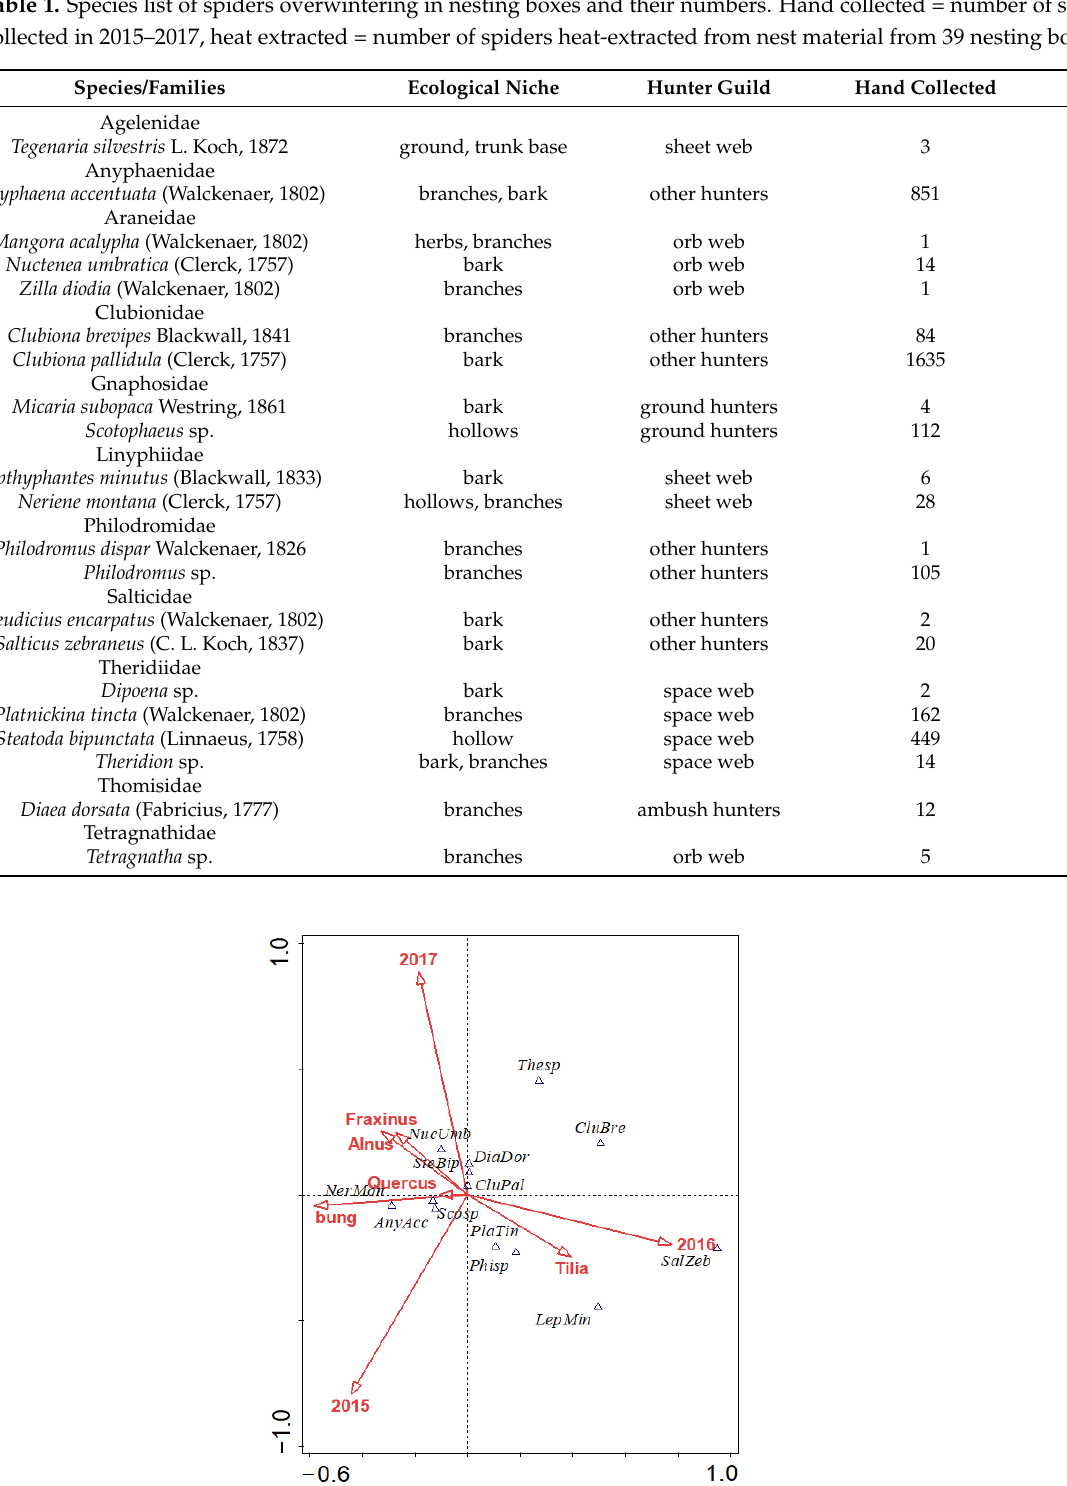
Figure 2. Comparison of the number of spider specimens per box and inspection (abundance = individuals) in bunged nesting boxes and boxes without a bung (sampled once in winter of 2015, 2016, and 2017), bold lines in the box plot are the median and the lines are 95% CI, the dots are outliers. 3.3. Effect of Temperature on the Nesting Box Resettlement by Spiders The temperature inside and outside of the nesting boxes did not difer significantly. Temperature had a significant effect on seven species active during winter (GAM: A . accentuata , F = 42, p < 0.001; C . pallidula , F = 31.4, p < 0.001; C . brevipes , F = 8, p < 0.001; P . tincta , F = 16.1, p < 0.001; S . bipunctata , F = 7.3, p < 0.001; Scotophaeus sp., F = 3.9, p = 0.021; Tetragnatha sp., F = 3.1, p = 0.046). The strongest positive effect on the resettlement of the